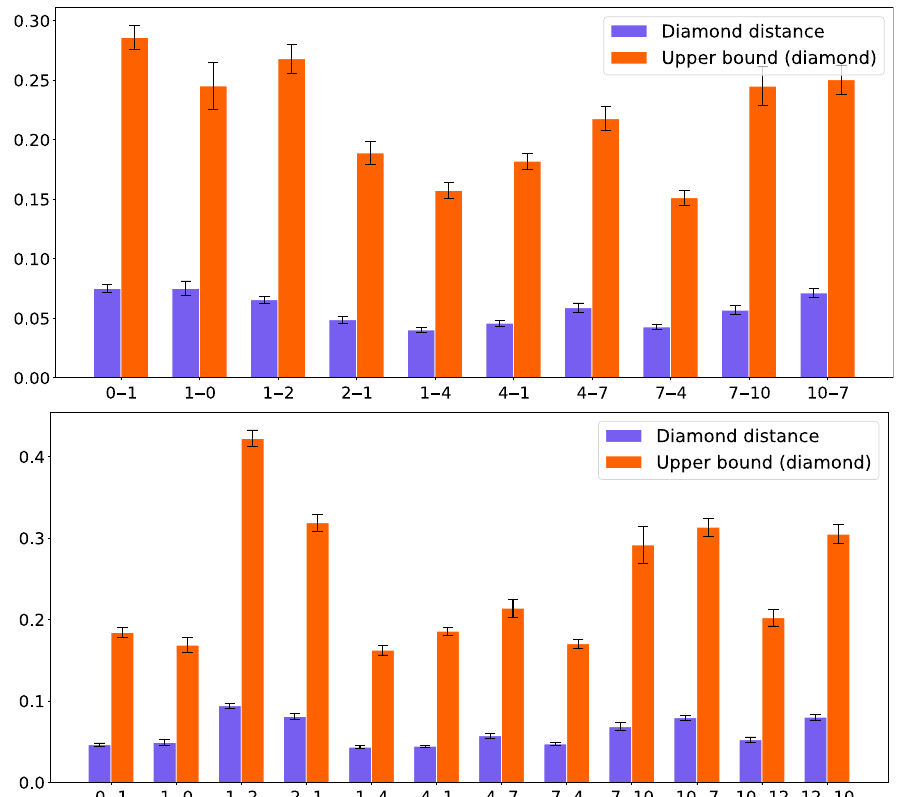
FIG. 14. The error analysis of the set of CNOT gates in IBMQ_GUADALUPE employed for the simulation of the first set of results in Fig. 2 (upper plot) and for the second set of results in Fig. 8 (lower plot). The tick 0–1 on the x axis corresponds to the CNOT gate, where “qubit 0” in IBMQ_GUADALUPE is the control qubit and “qubit 1” is the target. We plot the diamond distance between ideal and noisy CNOT s according to Eq. (4) (violet) and the corresponding upper bound based on the average gate fidelity and unitarity (orange), as defined in Eq. (14). The error bars in the plots are given by the standard deviations of 100 realizations of a random sample of the experimental data via